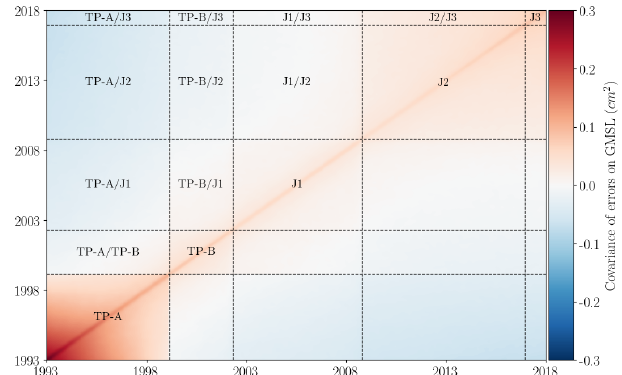
Figure 2. Error variance–covariance matrix of altimeter GMSL on the 25-year period (January 1993 to December